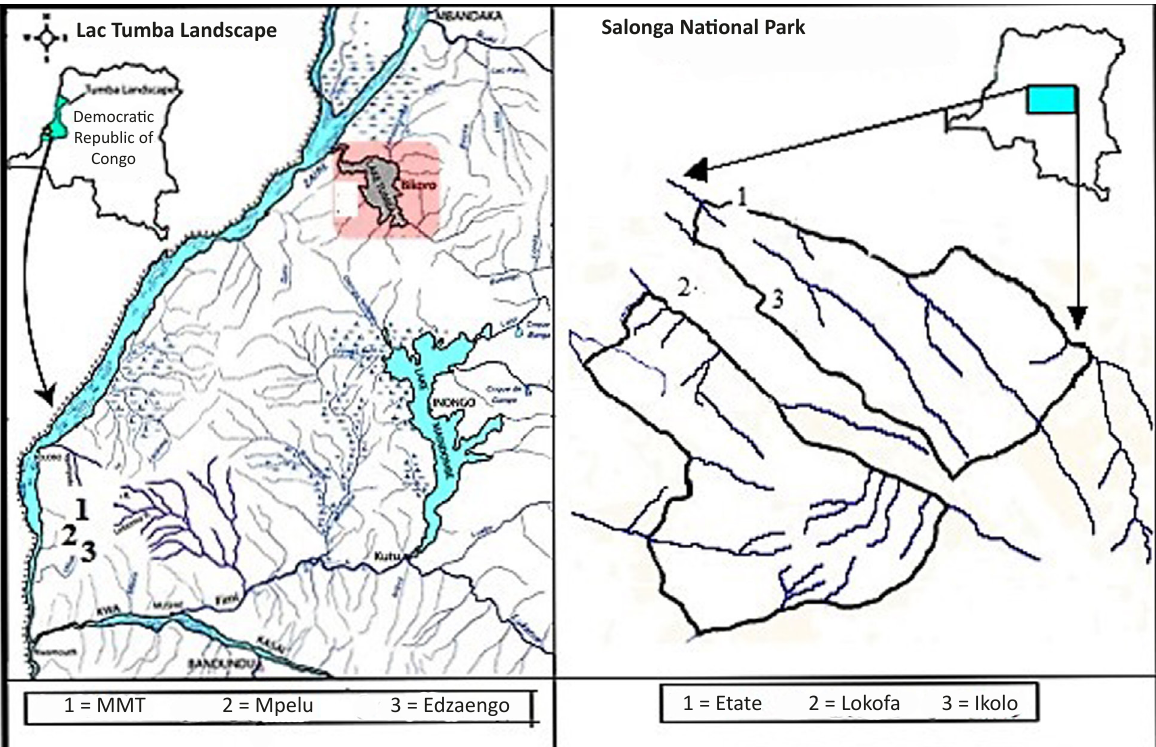
Figure 1. Lake Tumba landscape and Salonga National Park, Democratic Republic of